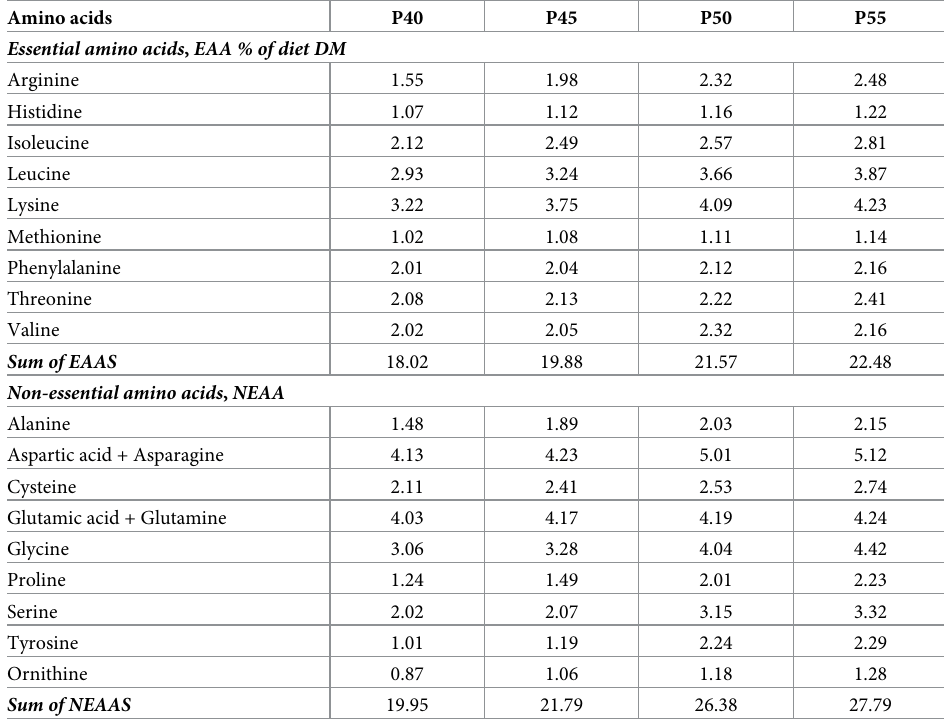
Table 2. Amino acid profile of the bullseye snakehead test diets (%, dry matter). Amino